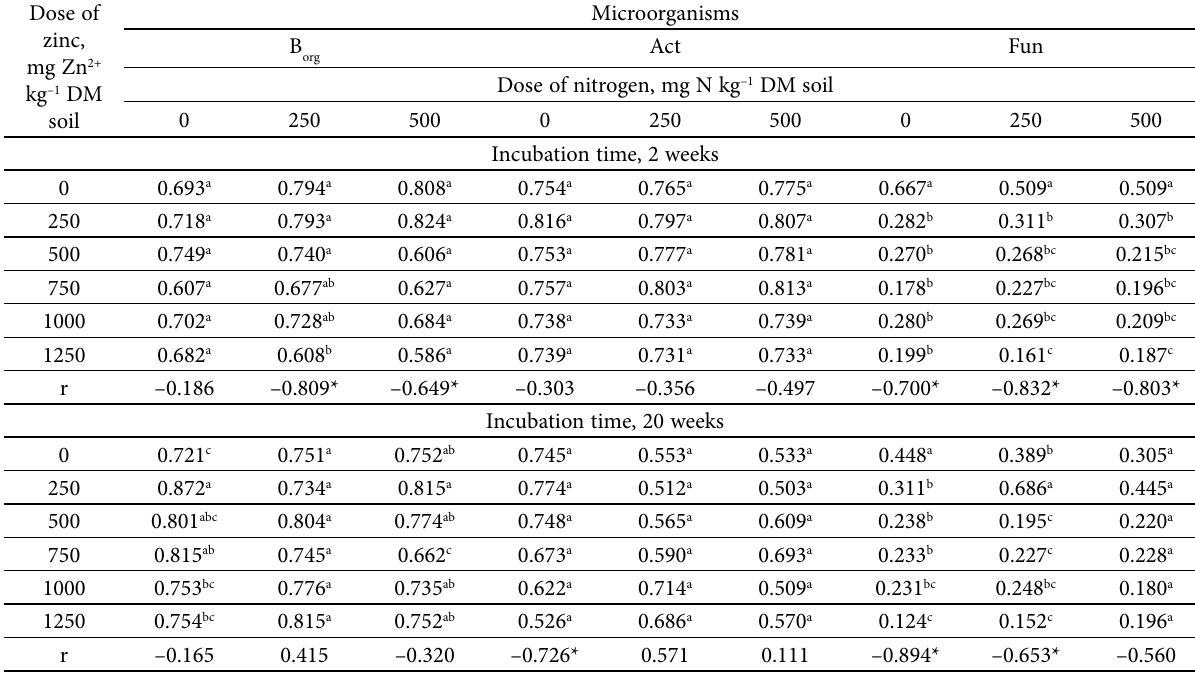
Table 3. Ecophysiological diversity (EP) index of microorganisms in the soil contaminated with zinc (the values are means of three replicates) Dose